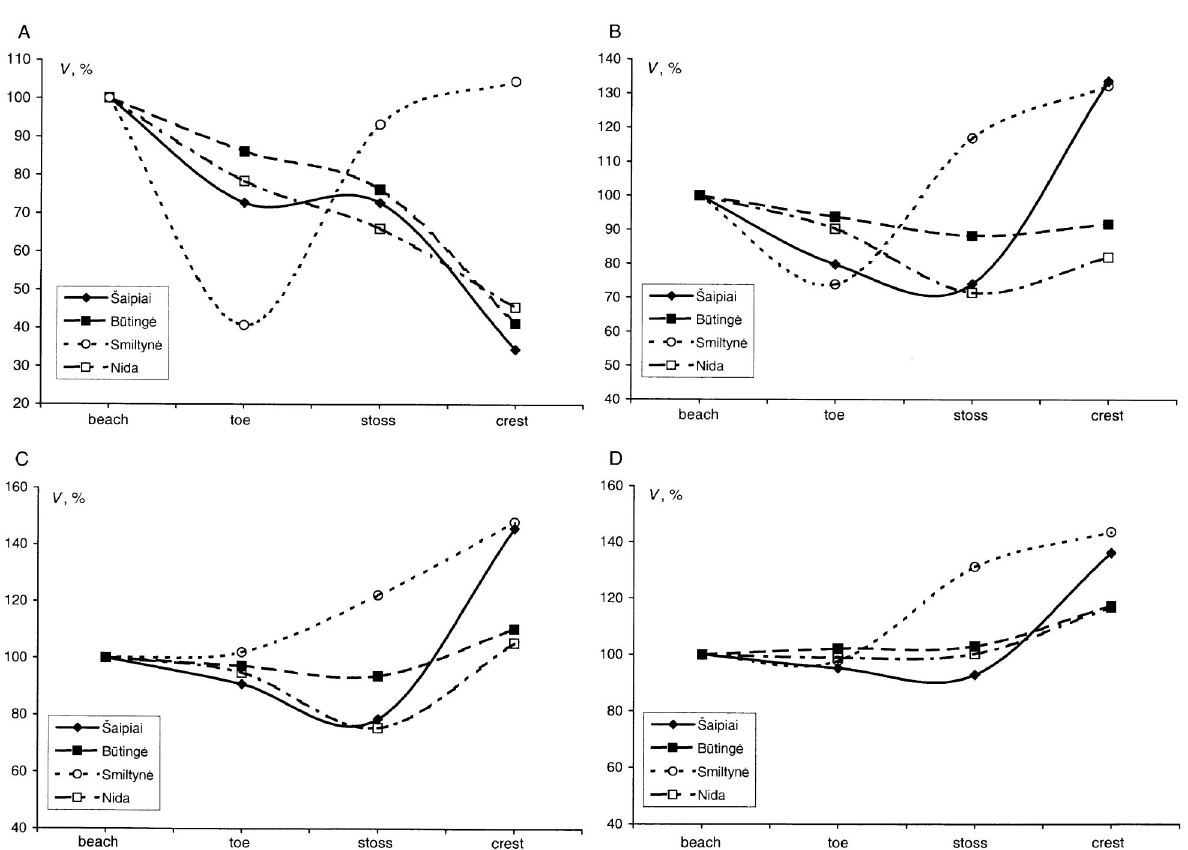
Fig. 9. Near-surface wind velocity dynamics in the coastal cross-shore profile with different foredune topography. A , 0.2 m height above surface; B , 0.5 m height; C , 1.0 m height; D , 2.0 m height. Wind velocity ( V ) is given in per cent from the middle of the